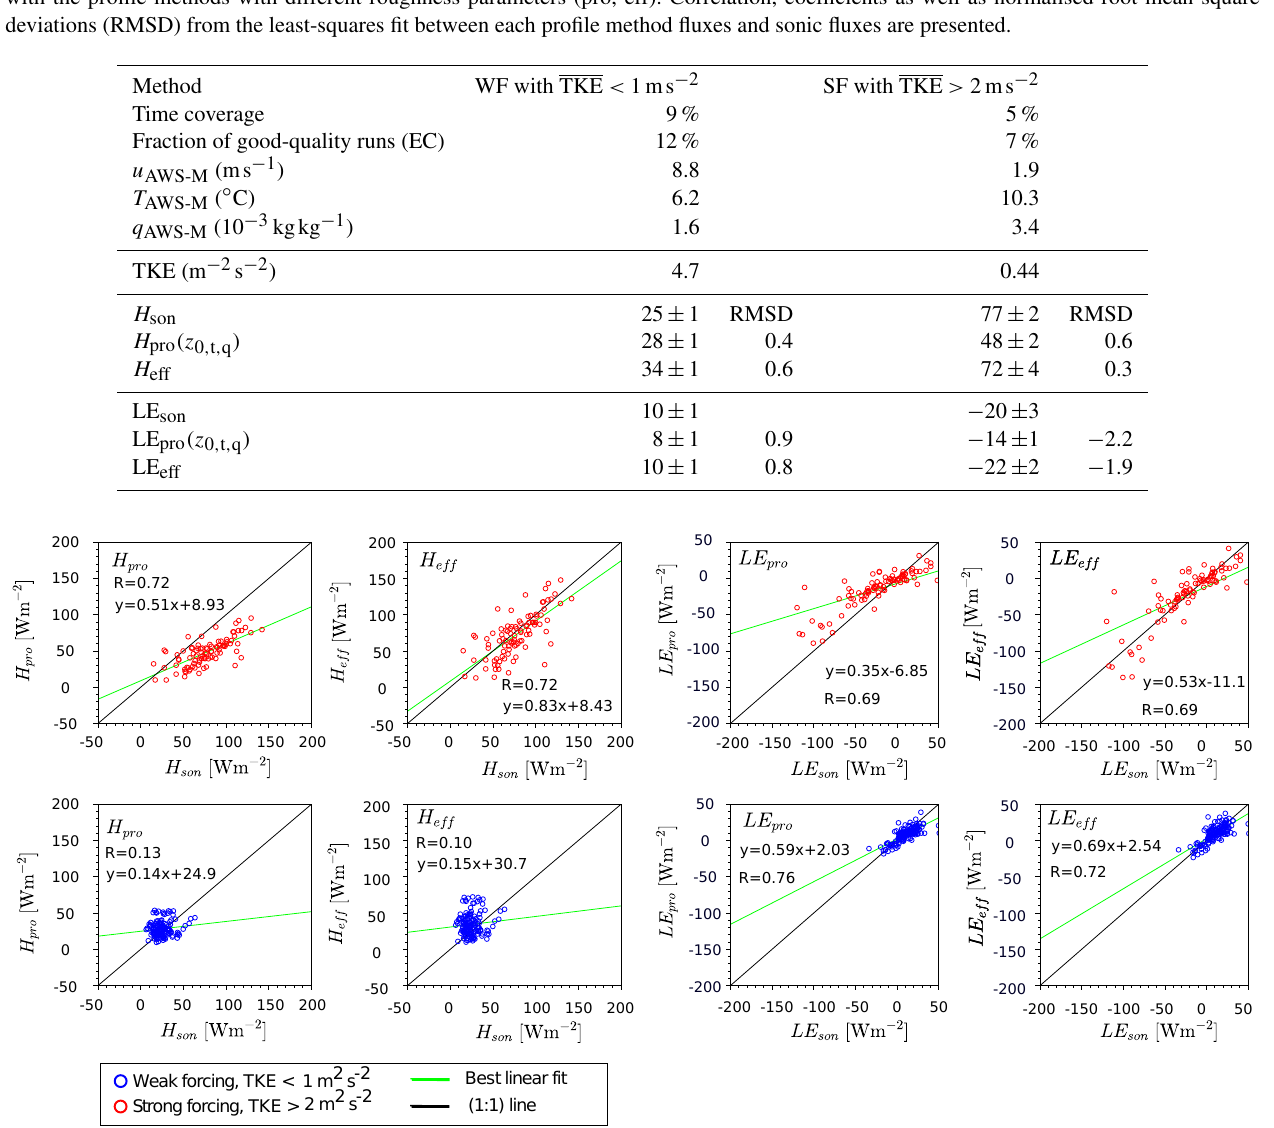
Figure 7. Comparison of hourly reference H , LE pro and H , LE eff fluxes from the profile method with the fluxes H , LE son measured with the EC, during the 2006 field campaign. Red and blue circles fluxes represent results during the SF cases when TKE was high and WF cases when TKE was low respectively. Black lines are the 1 : 1 lines and green lines are the regressions. Equations for these lines and correlation coefficients are also